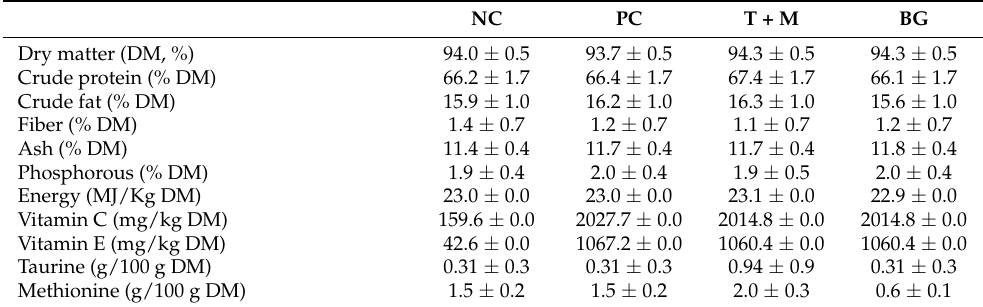
Table 2. Proximate composition of the experimental diets used to culture whiteleg shrimp ( P. vannamei ) PL for 18